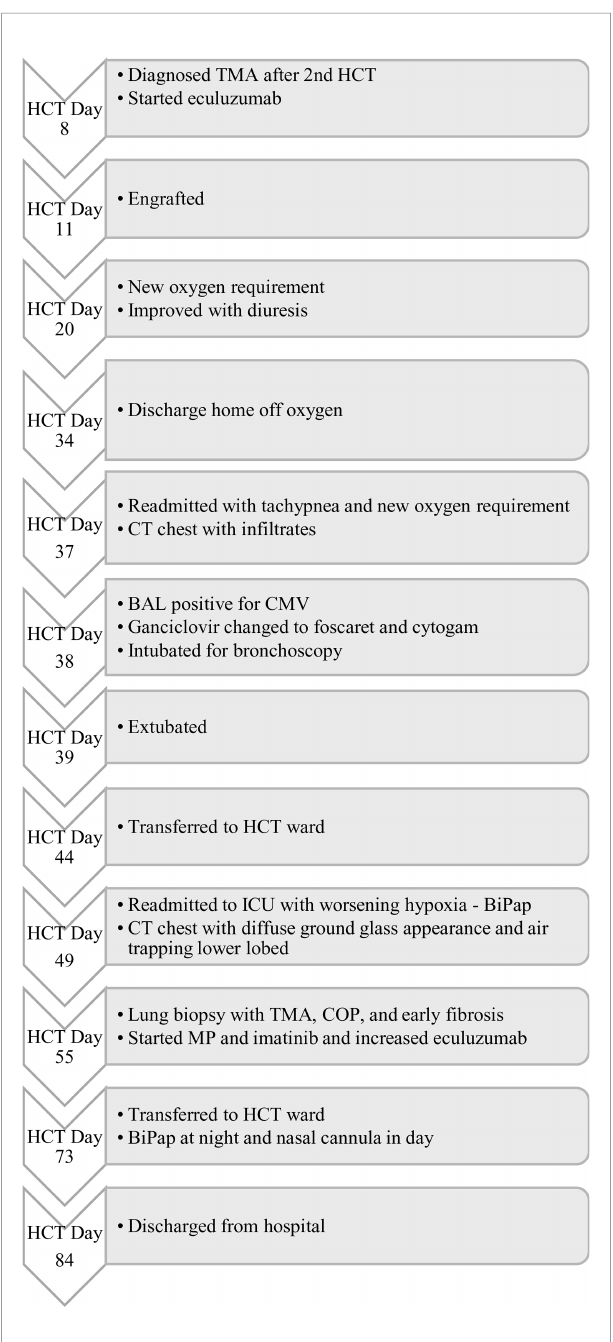
FIGURE 3 | Timeline of events for ICU